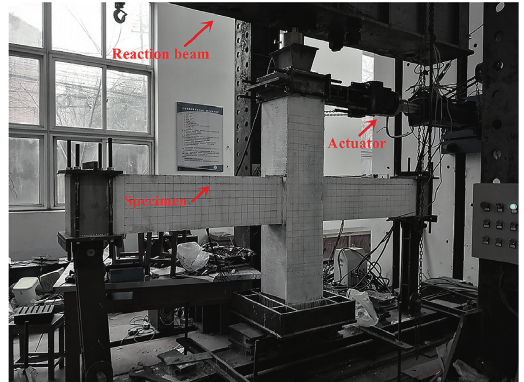
Figure 5: Test on-site.